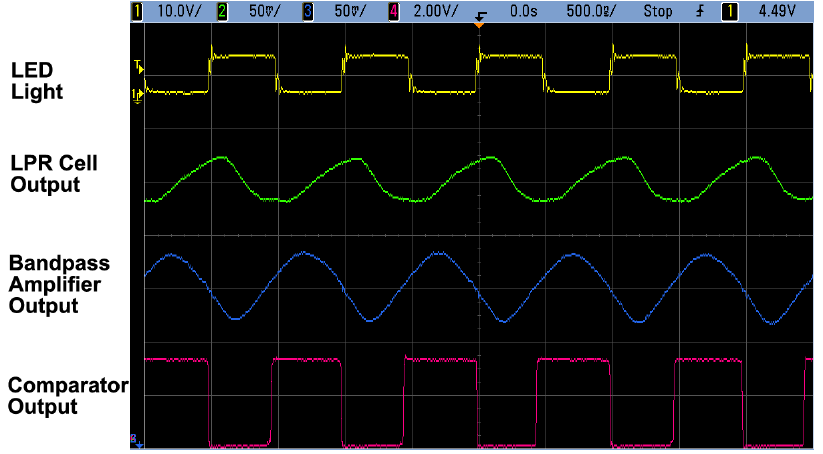
Figure 19. Waveformes of communication signals.